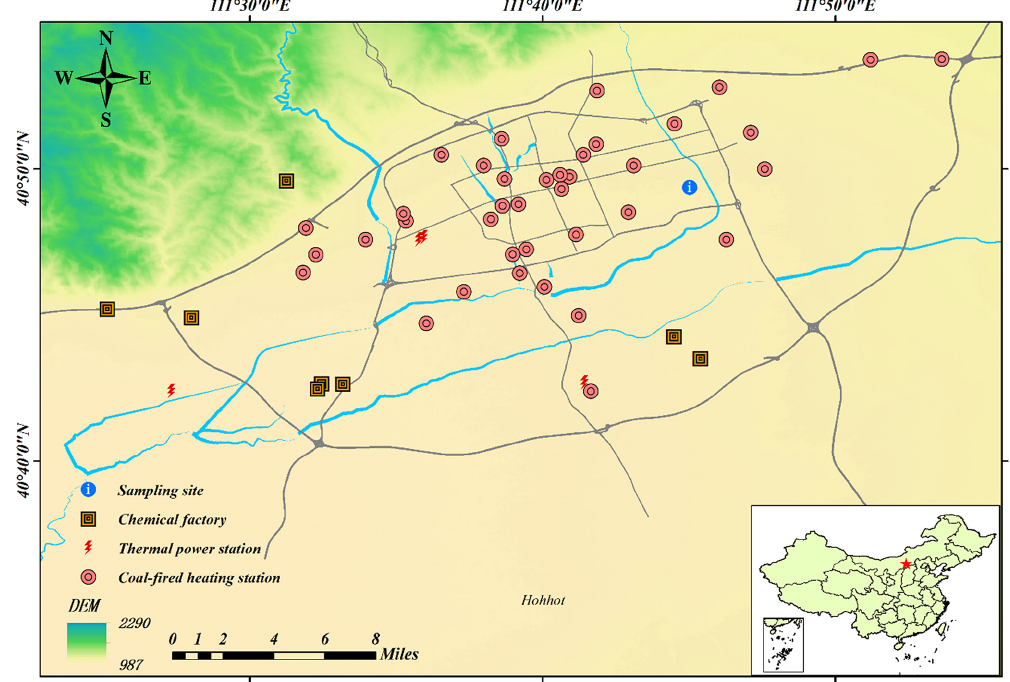
Figure 1. Map of sampling sites and coal-fired